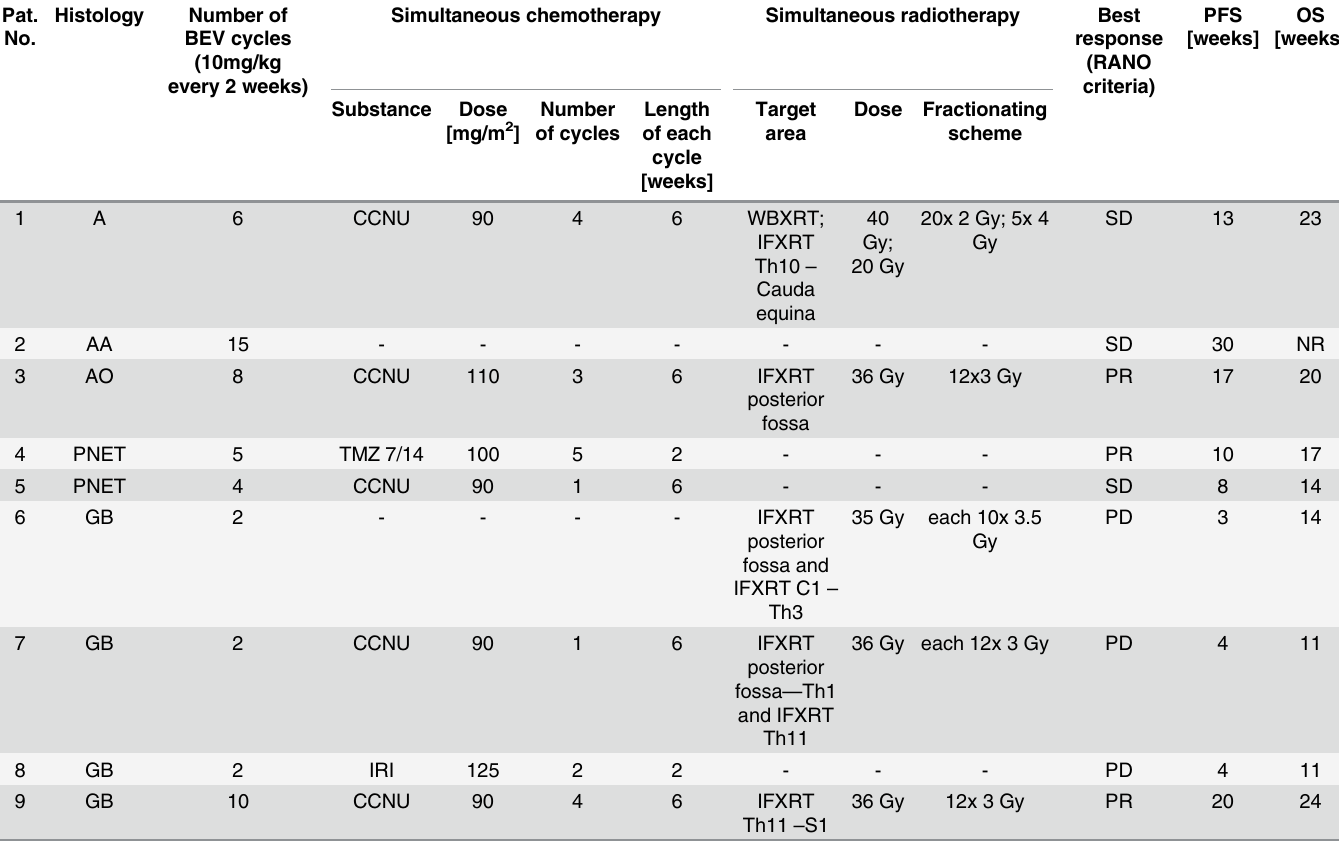
Table 2. Treatment and outcome. Pat. No.